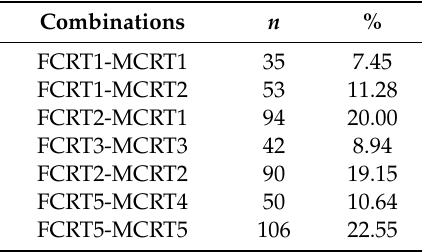
Table 8. Combinations of parent-child relation type between father and mother ( n = 494 ).